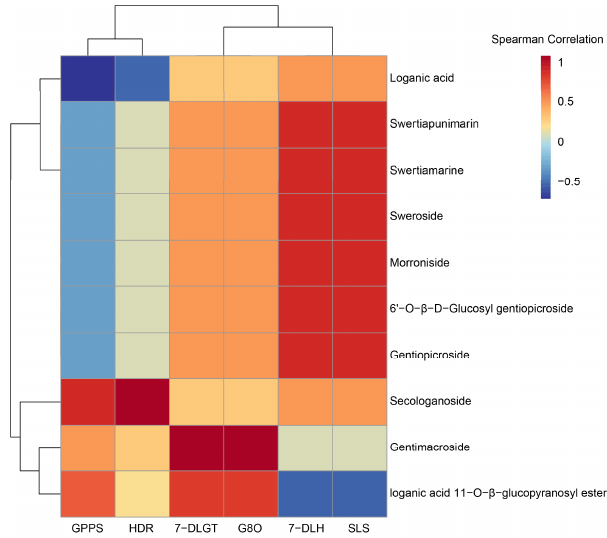
Figure 11. Cluster analysis of the expression of six key enzyme genes ( HDR , GPPS , G8O , SLS , 7-DLGT , and 7-DLH ) related to the contents of ten iridoids. Red and blue represent positive and negative correlations, respectively.